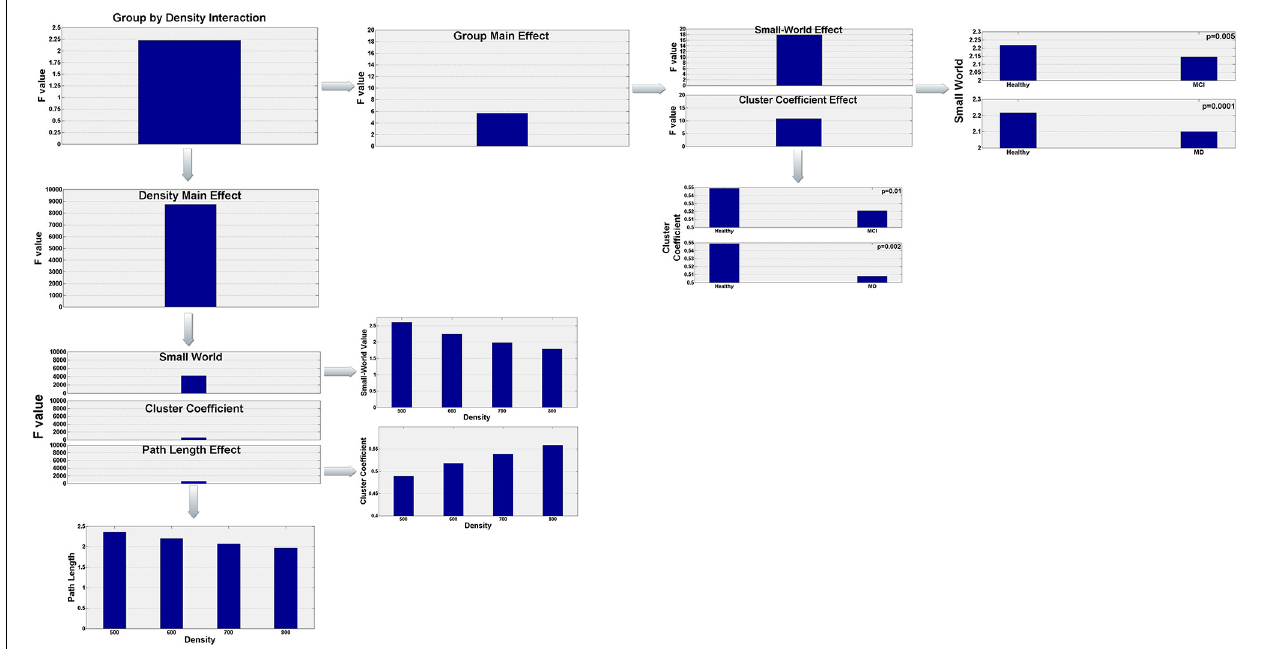
FIGURE 3 | Visualization of the statistically significant network parameters results (Small-World, Characteristic Path Length, Cluster Coefficient). Results refer to network differences among the three groups (Healthy, aMCI, MD) and are dependent on the density parameter ( N = 500, 600, 700, 800). More specifically, statistical